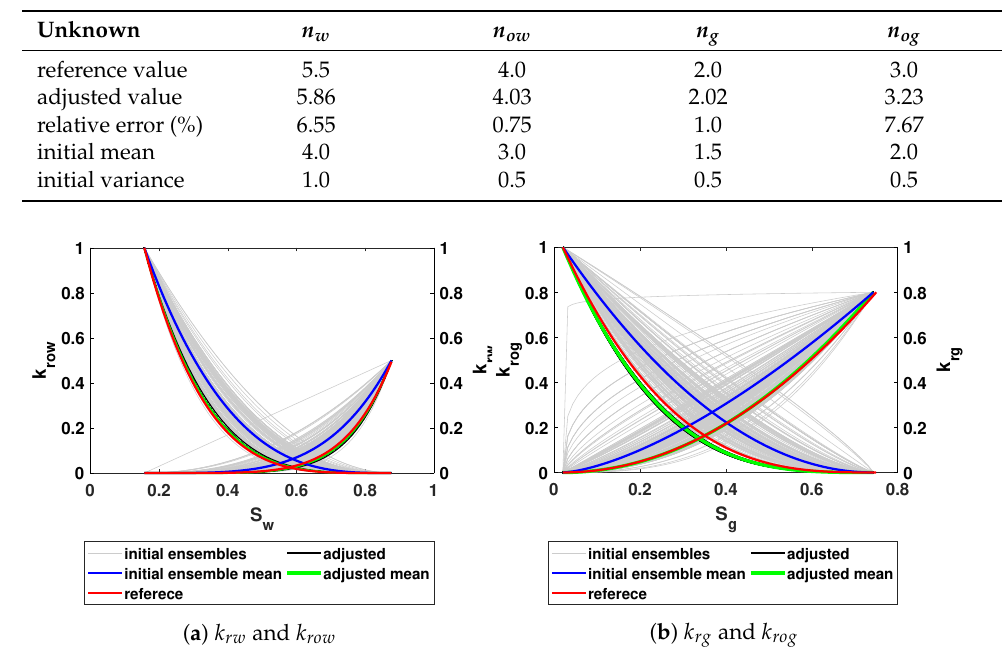
Figure 5. Initial ensembles, initial ensemble means, adjusted values and reference values with known endpoints: ( a ) k rw and k row ; ( b ) k rg and k rog